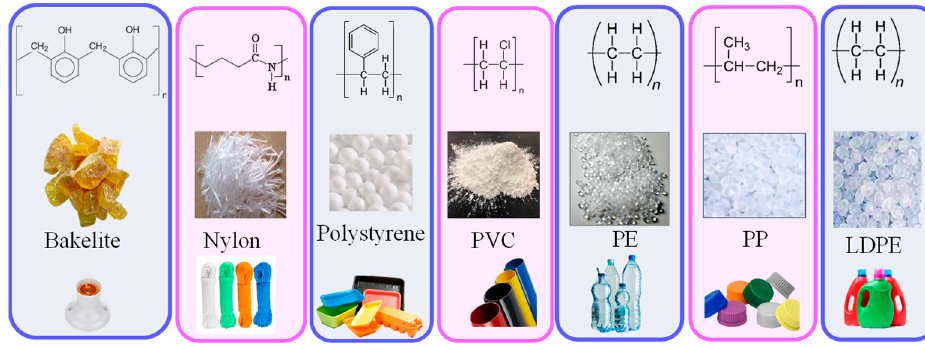
Figure 11. Different categories of thermoplastics and their popular applications.